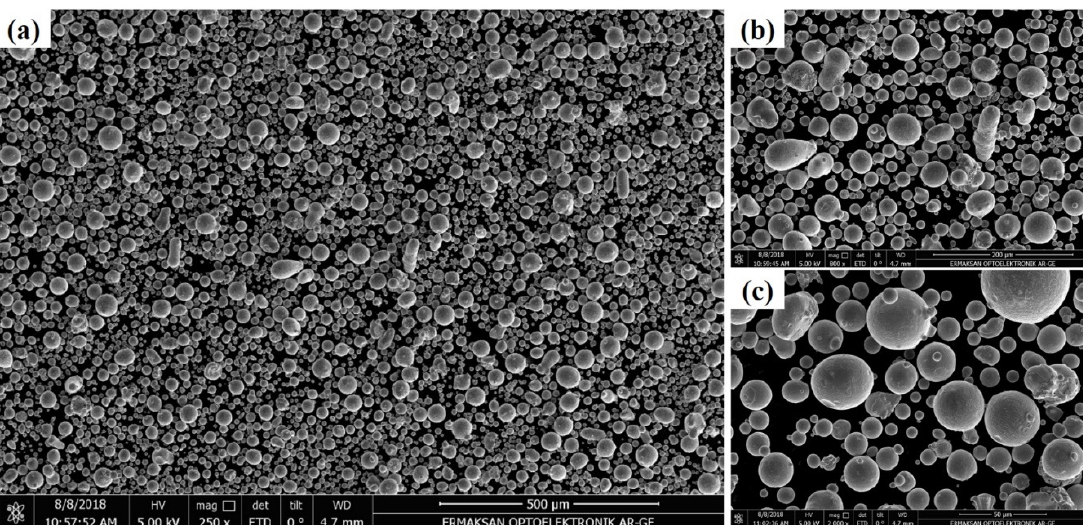
Figure 6. SEM images of Co–Cr powder particles ( a ) 500 μ m, ( b ) 200 μ m and ( c ) 50 μ m.